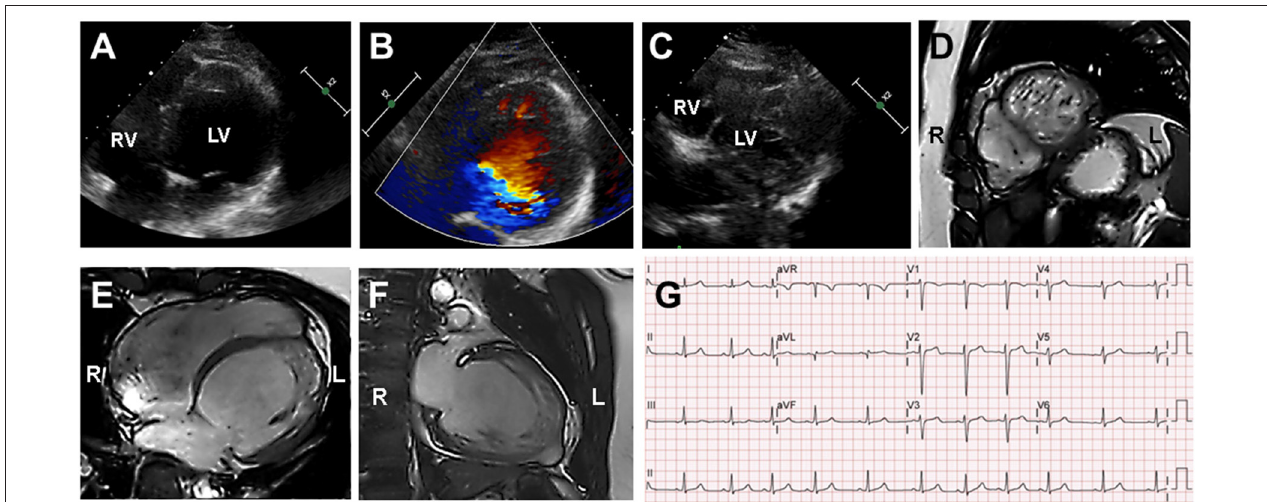
FIGURE 2 | Echocardiography and cardiac magnetic resonance imaging (cMRI) in the proband (III-2). (A–C) Echocardiography and Color Doppler showed dilated left ventricle chamber and prominent trabeculation and flow within the deep intertrabecular recesses. (D–F) cMRI revealed that the non-compacted to compacted ratio ≥ 2 and severely dilated biventricular myocardium that was compatible with dilated LVNC. (G) Proband’s electrocardiogram demonstrated sinus arrhythmia and non-specific intraventricular conduction